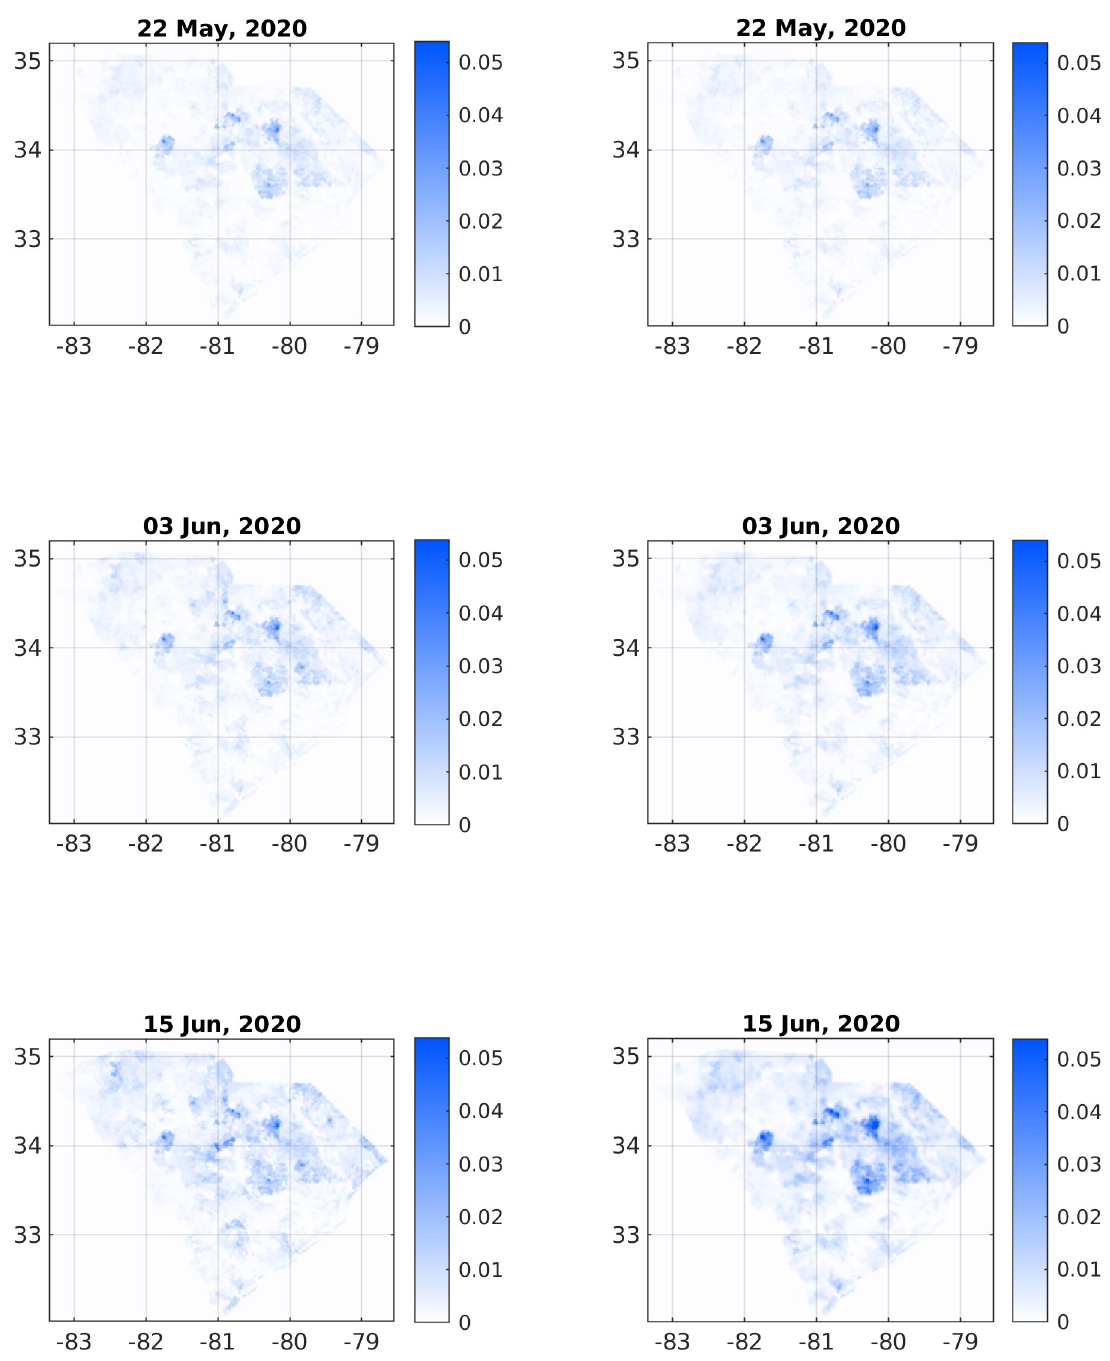
Fig 3. Comparison of infection dynamics between the data from the DHEC (left column) and the theoretical model (right column). In both columns, images correspond to the sum f ( x ) + w ( x ) + r ( x ). The heading for each panel shows the date, starting from May 22, 2020, corresponding to relative times t = 0, t = 12, and t = 24 days. See later times in Fig 4.